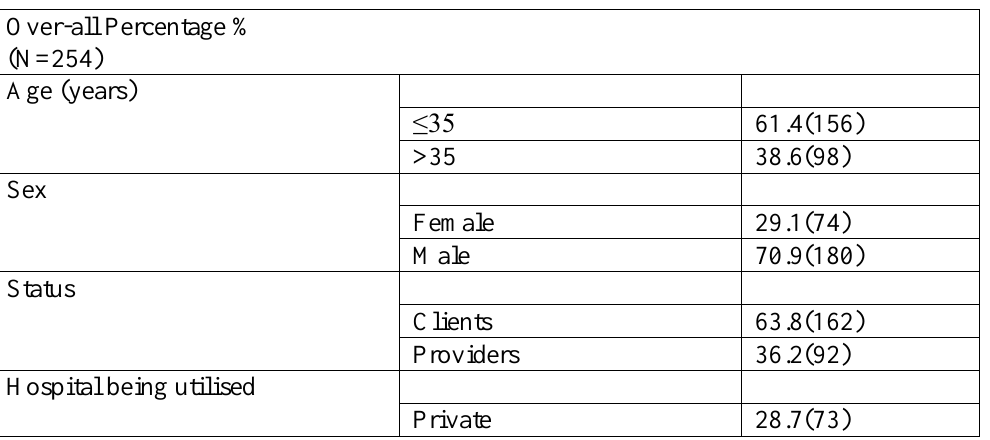
Table 1: Respondents’ baseline